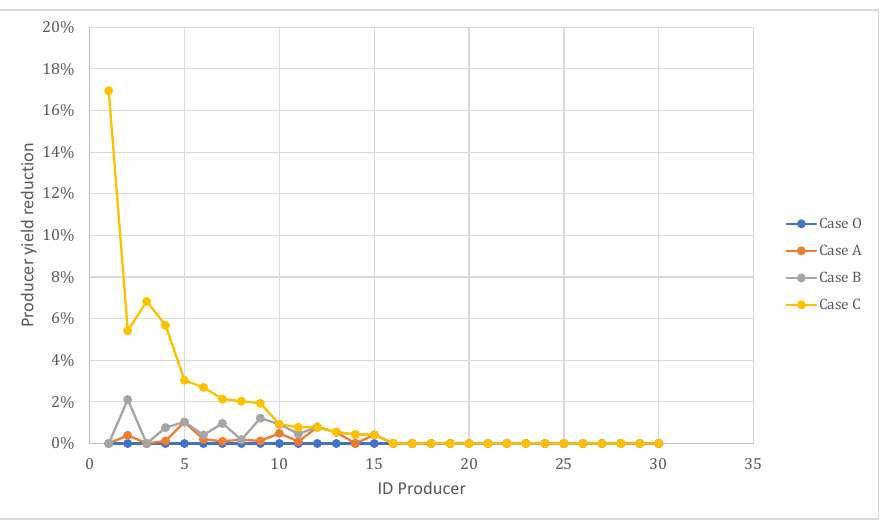
Figure 11. Producers’ yield reduction